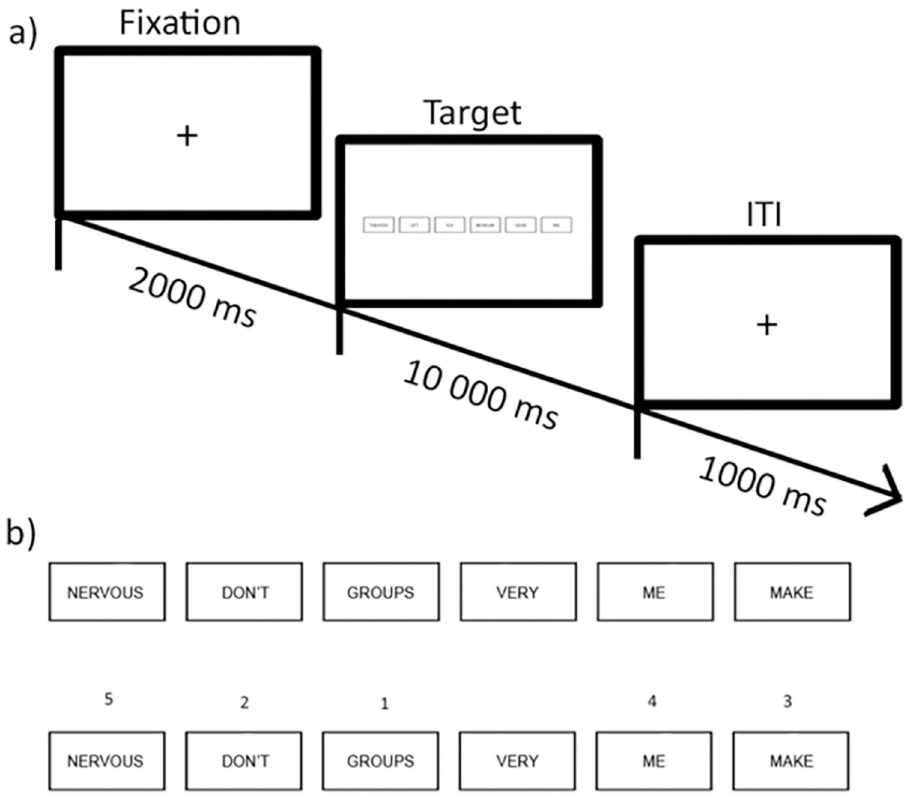
Fig 1. Experimental set-up of the SST. Schematic flow of a trial in the Scrambled Sentence Task (a) and example Target displays (b). Participants are presented with a scrambled sentence (see top line of Panel b) and required to click on five of the six words in an order that produces a grammatically correct sentence (see bottom line of Panel b). In this display, the sentence (“nervous don’t groups very me make”) is unscrambled in a positive fashion (“groups don’t make me